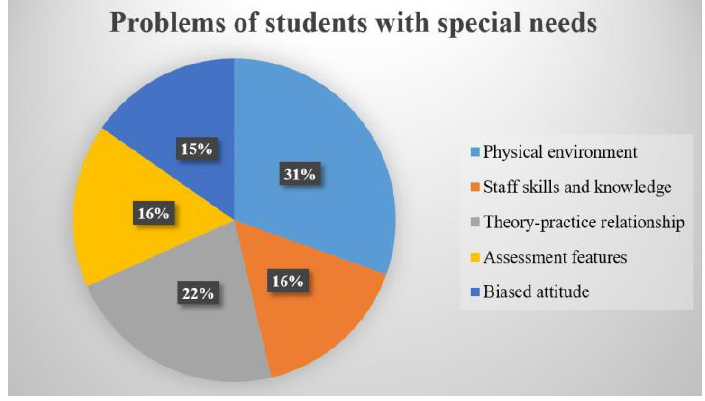
Fig. 1. Most Common Problems of Disabled Engineering